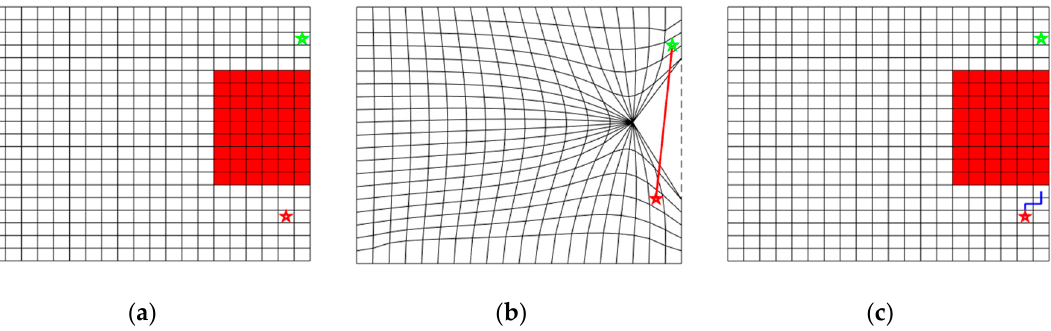
Figure 5. Non-convex DC-space situation. ( a ) The obstacle is connected with one boundary of C-space. ( b ) The generated DC-space after deforming the obstacle, and one path (red line) connects the start point (red star) and the target point (green). ( c ) The path is generated in C-space after mapping back from DC-space. The path stops extending when reaching the boundary.